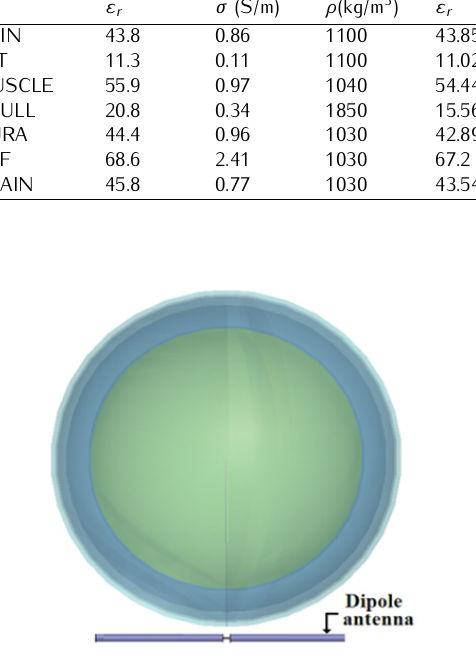
Table 1. The properties of the materials used in the simulations. Type of tissue